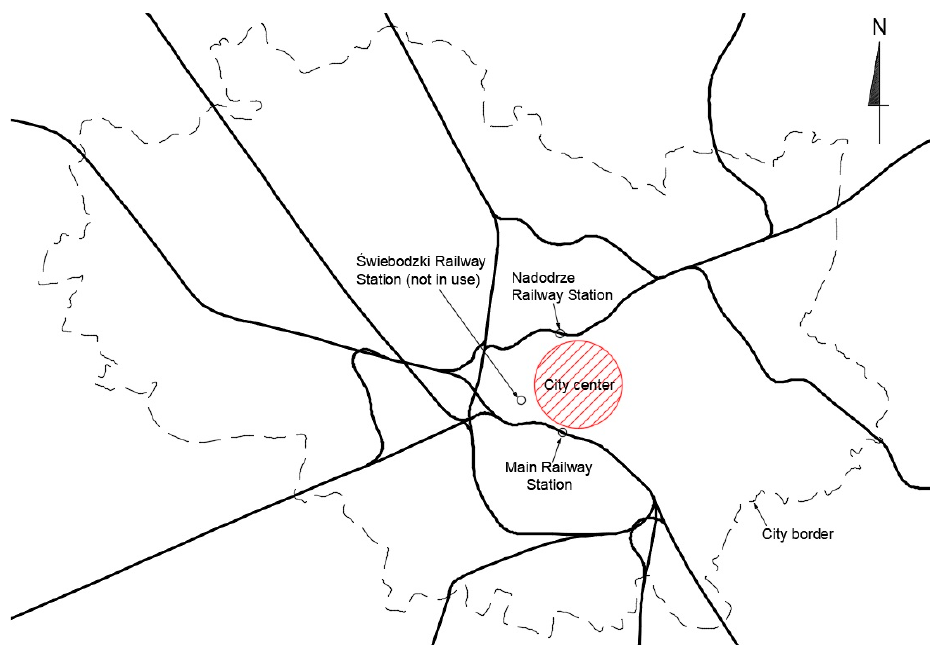
Figure 3. The Wroc ł aw Railway Junction